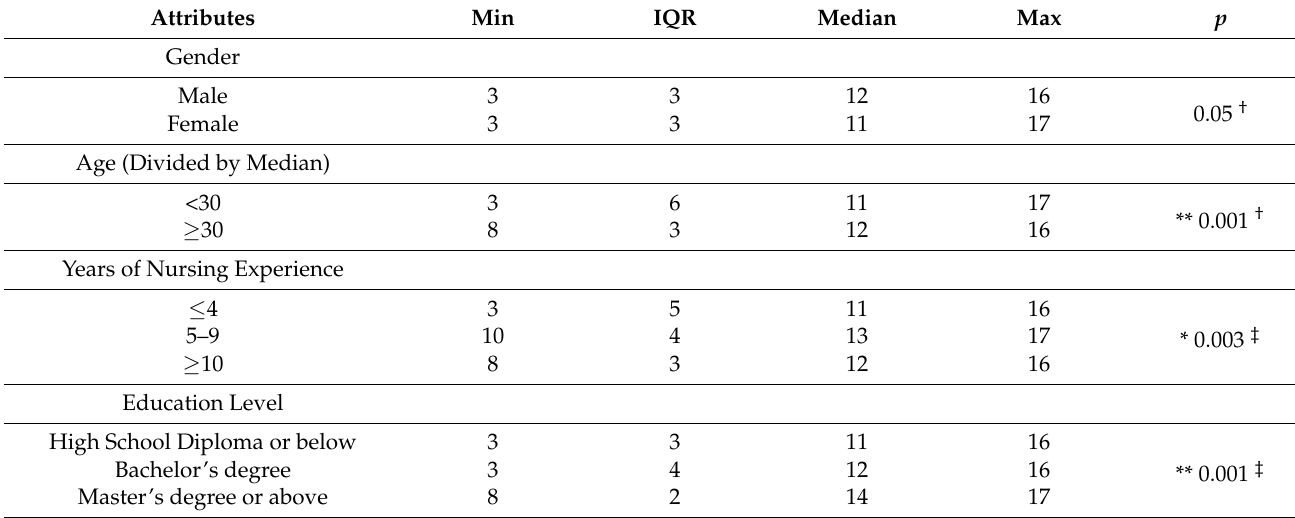
Table 3. Comparison of the knowledge section according to nurses’ demographic